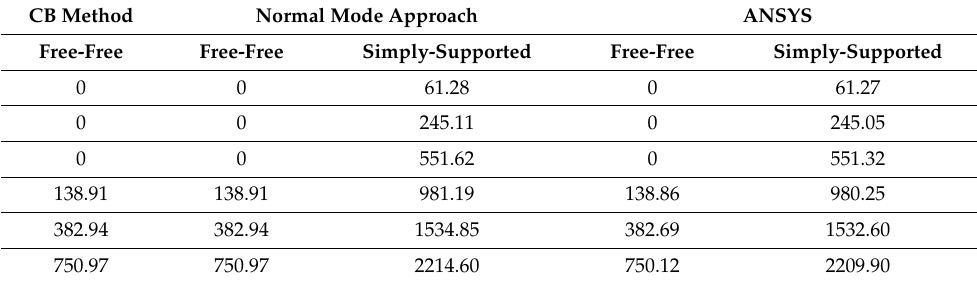
Table 2. Comparative analysis of the frequencies from different methods (Hz).